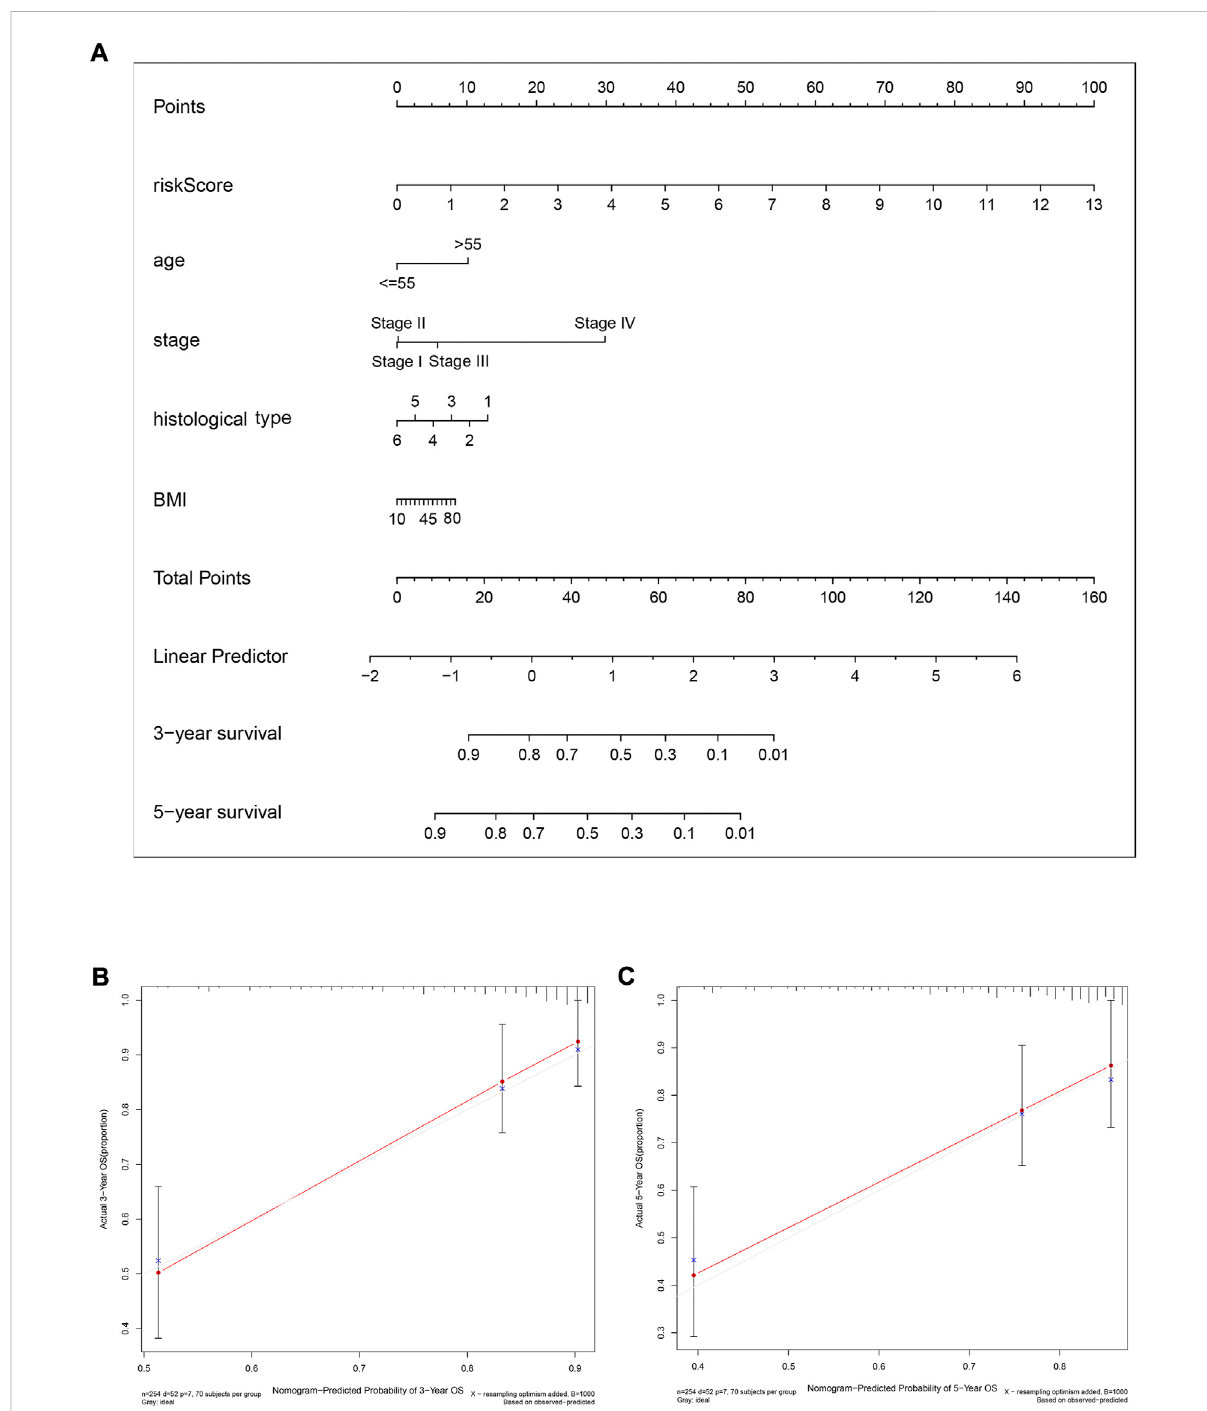
FIGURE 9 A nomogram (inclusive of risk score) for predicting OS in cervical cancer patients. (A) A nomogram comprising the risk score and other clinical factors for predicting the 3-year and 5-year OS of CC patients. (B and C) Calibration plots of the nomogram for predicting 3-year (B) and 5-year (C) survival ofCCpatients. The x -axisrepresents nomogram-predicted survival,andthe y -axisrepresentsactual survival.TheC-index ofthenomogram for predicting survival is